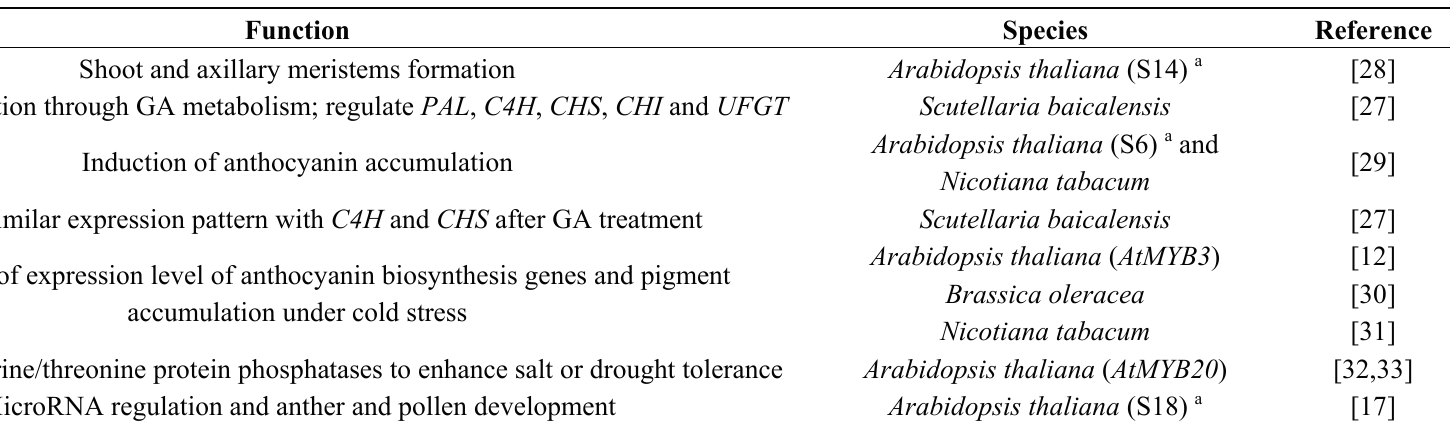
Table 2. Putative functions of Scutellaria